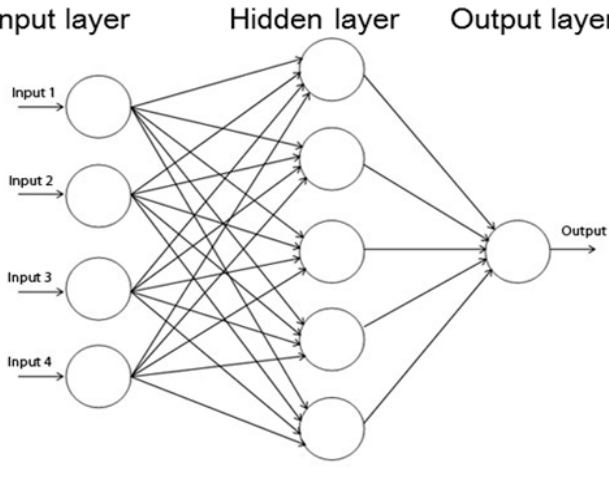
Figure 4. Concept of multilayer perceptron.